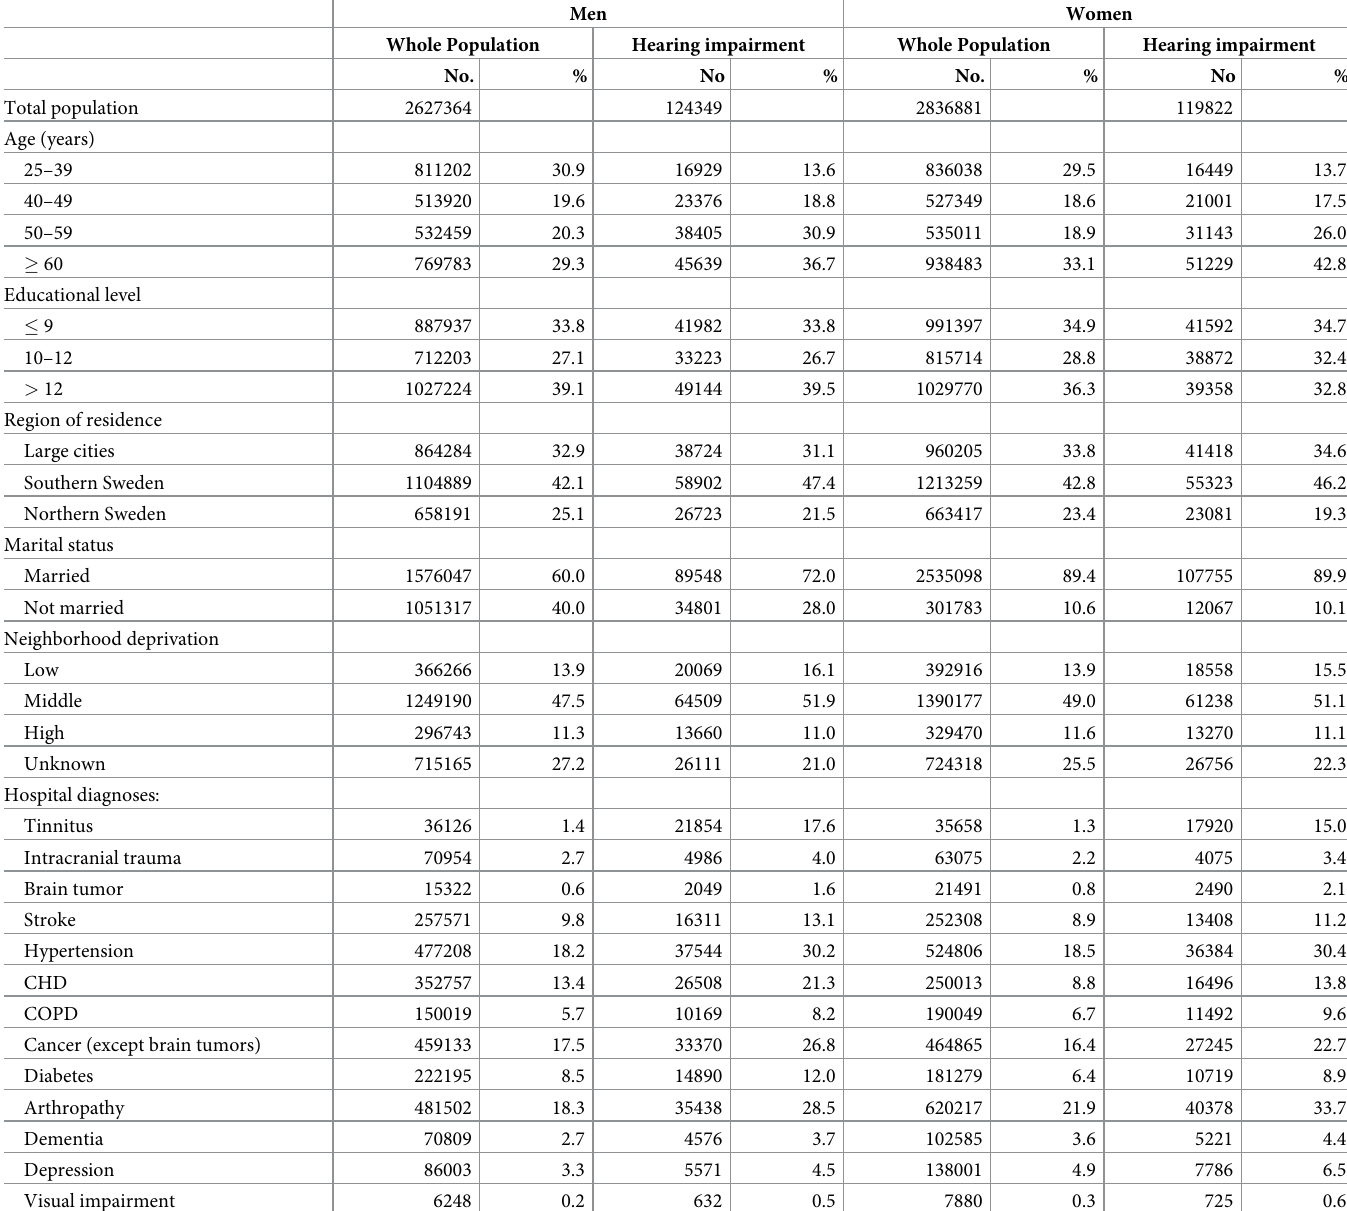
Table 1. Study population and number of cases with hearing impairment categorized by